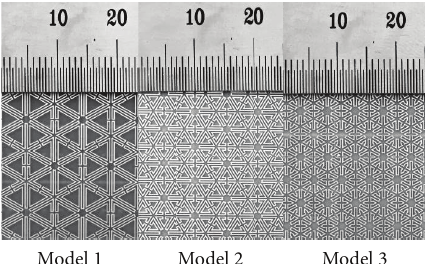
Figure 5: Fabrication of the proposed FSSs.